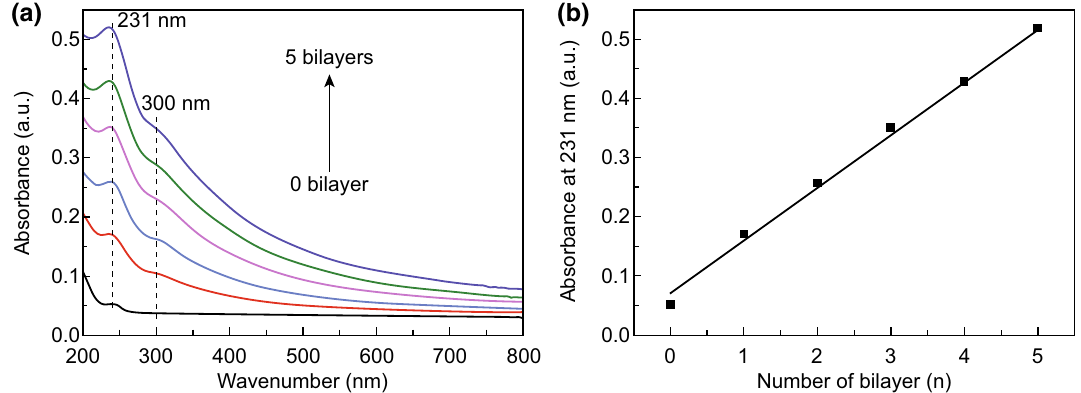
Fig. 5 a UV–Vis spectra of GO-based multilayers deposited on PVA substrate and b absorption intensity at 231 nm as a function of bilayer